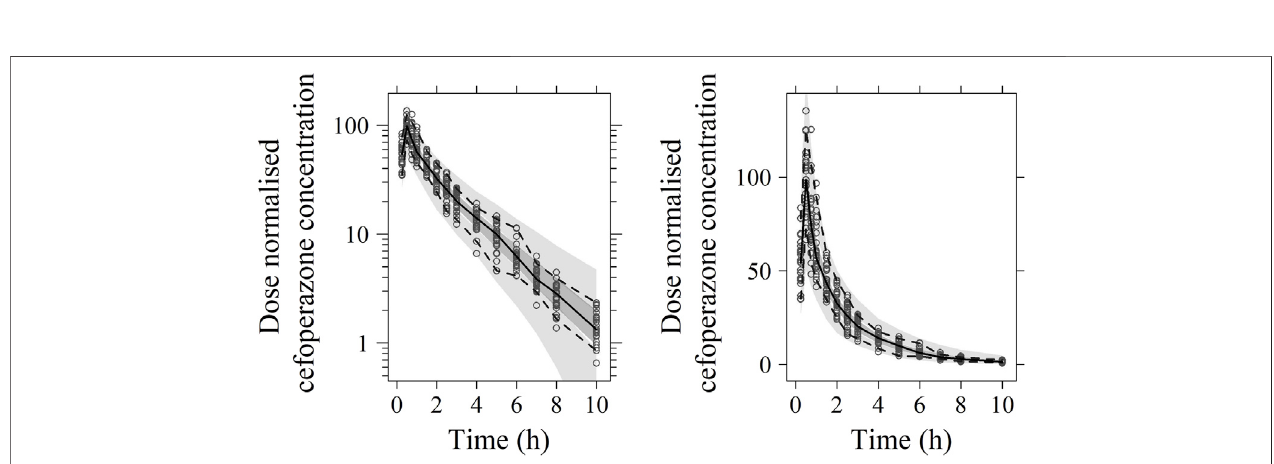
FIGURE 3 | Visual predictive check (VPC) of cefoperazone PK model (left: in logarithmic scale; right: in arithmetic scale). The range between the dashed lines depicts the 90th percentile intervals. The solid lines represent the medians of simulated data. Circles represent the observed data.